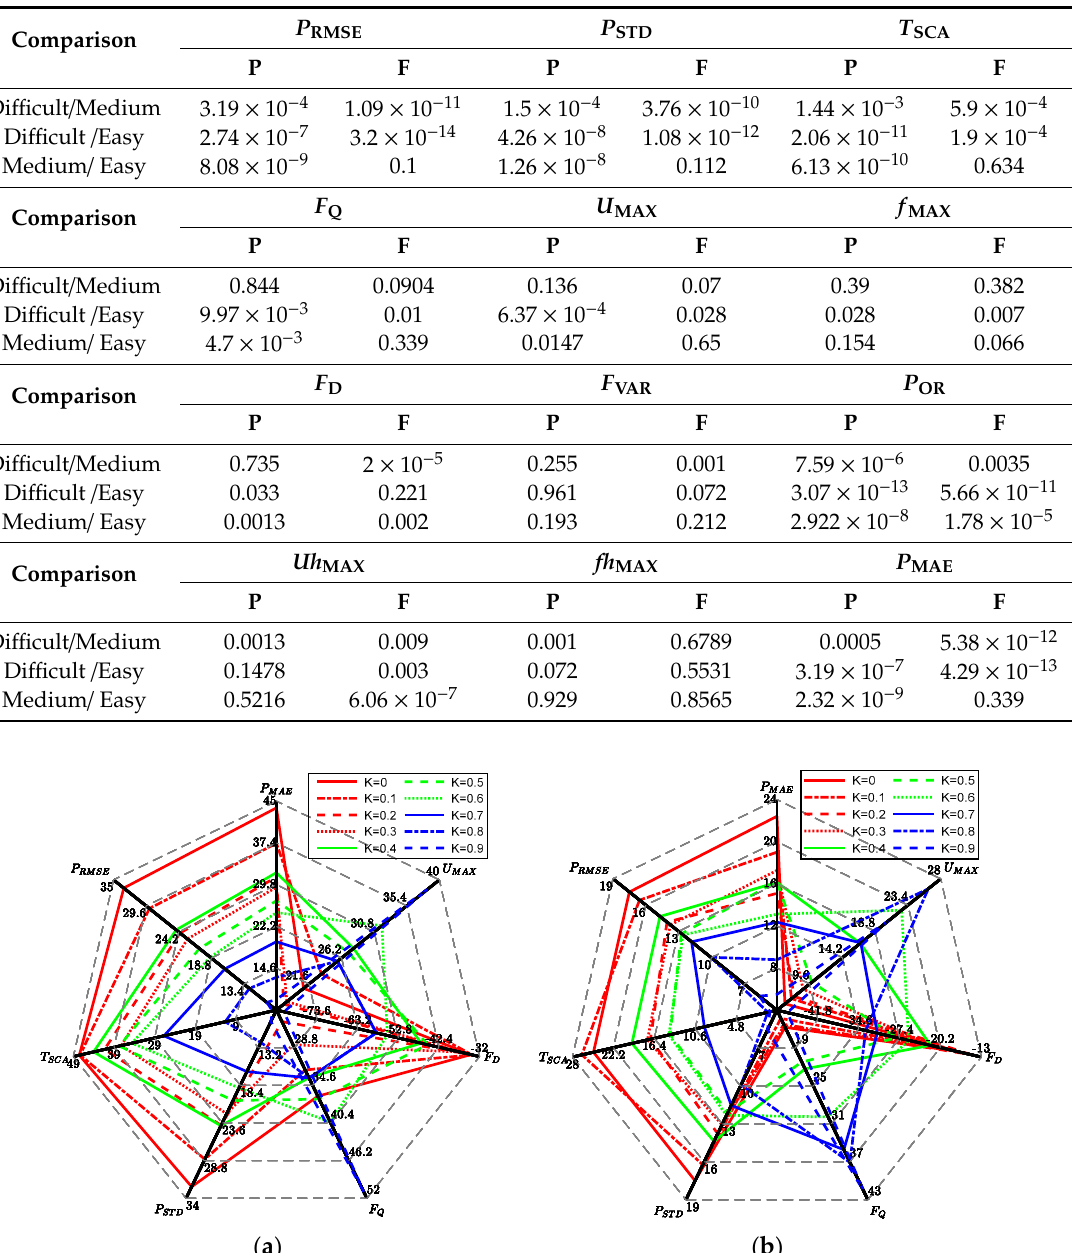
Figure 11. Characteristic quantity of training data under different task difficulties: ( a ) characteristic quantity of Volunteer 1 # training data; ( b ) characteristic quantity of Volunteer 2 # training data.